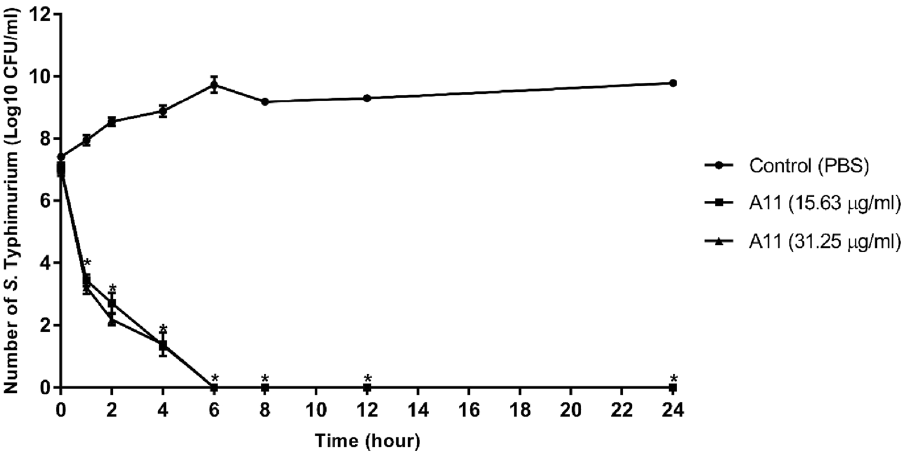
ml, respectively, while the MIC of nisin was 16,000 µg/ml. Nisin had no antimicrobial activity against any of the 16 tested drug-resistant S . enterica isolates (up to maximum concentration of 16,000 µg/ml). In contrast, peptide A11 displayed potent antimicrobial activity against all bacterial strains tested with MICs ranging from 62.5 to 125 μg/ml. Time‑kill kinetics. The time course of inhibition by A11 toward S . Typhimurium was investigated. As shown in Fig. 3, the control group (no peptide) showed a constant increase in growth, whereas [at MIC and MBC